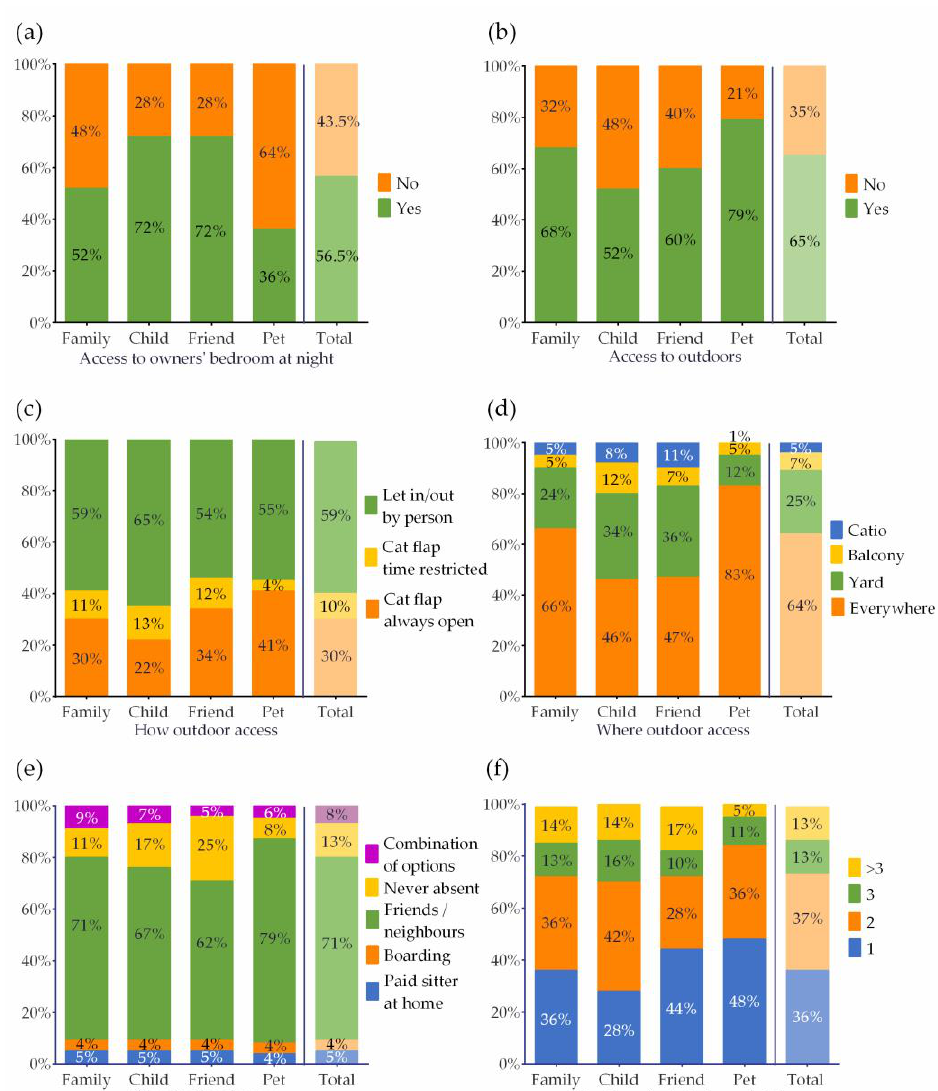
Figure 2. Aspects of the cat’s living environment. ( a ) access to owner’s bedroom at night, ( b ) outdoor access yes/no, ( c ) outdoor access how, ( d ) outdoor access where, ( e ) care during owner’s absence, and ( f ) multi-cat household, by relationship